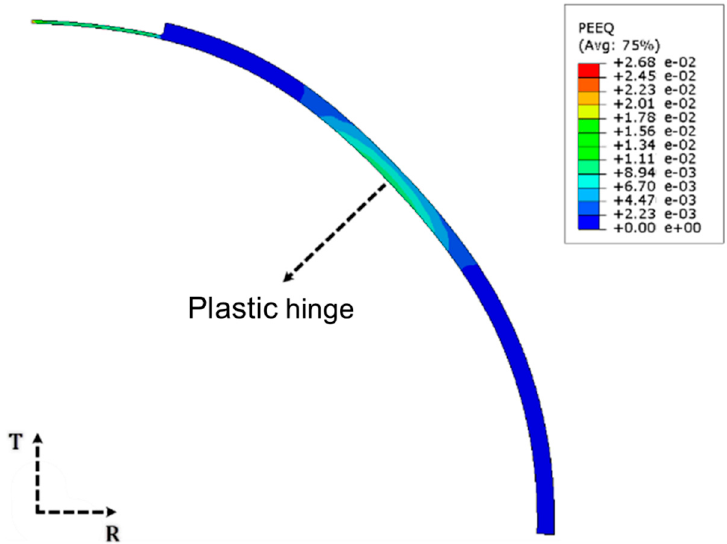
Figure 14. Plastic strain distribution through the mid-side section of SM1.